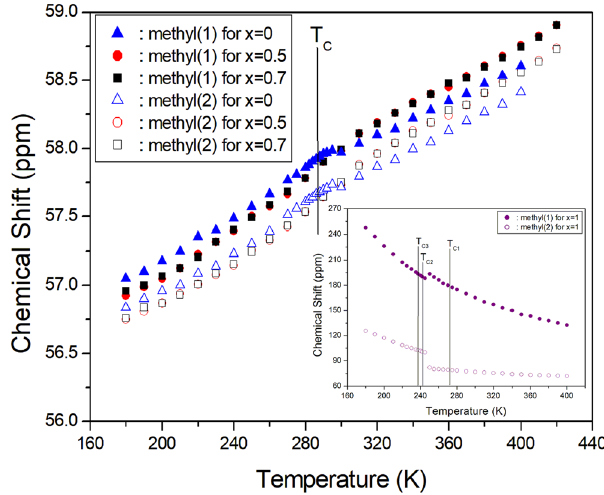
Figure 6. Chemical shifts of the 13 C CP/MAS NMR spectrum as a function of temperature for [N(CH 3 ) 4 ] 2 Zn 1- = 0, 0.5, and 0.7). Inset: Chemical shifts of the 13 C CP/MAS NMR spectrum as a function of x Cu x Br 4 ( x temperature for